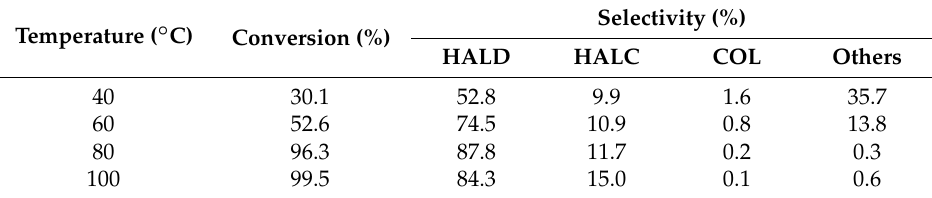
Table 5. Effect of reaction temperature on activity over 0.2%Pd-1.2%Ni/SBA-15 a